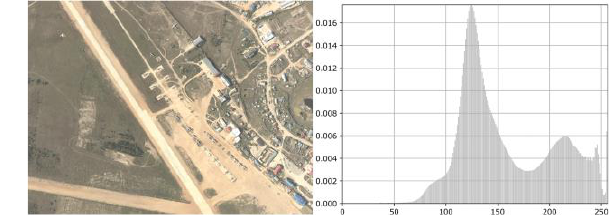
Figure 10. An image with lack of radiometric range in illumination and it’s